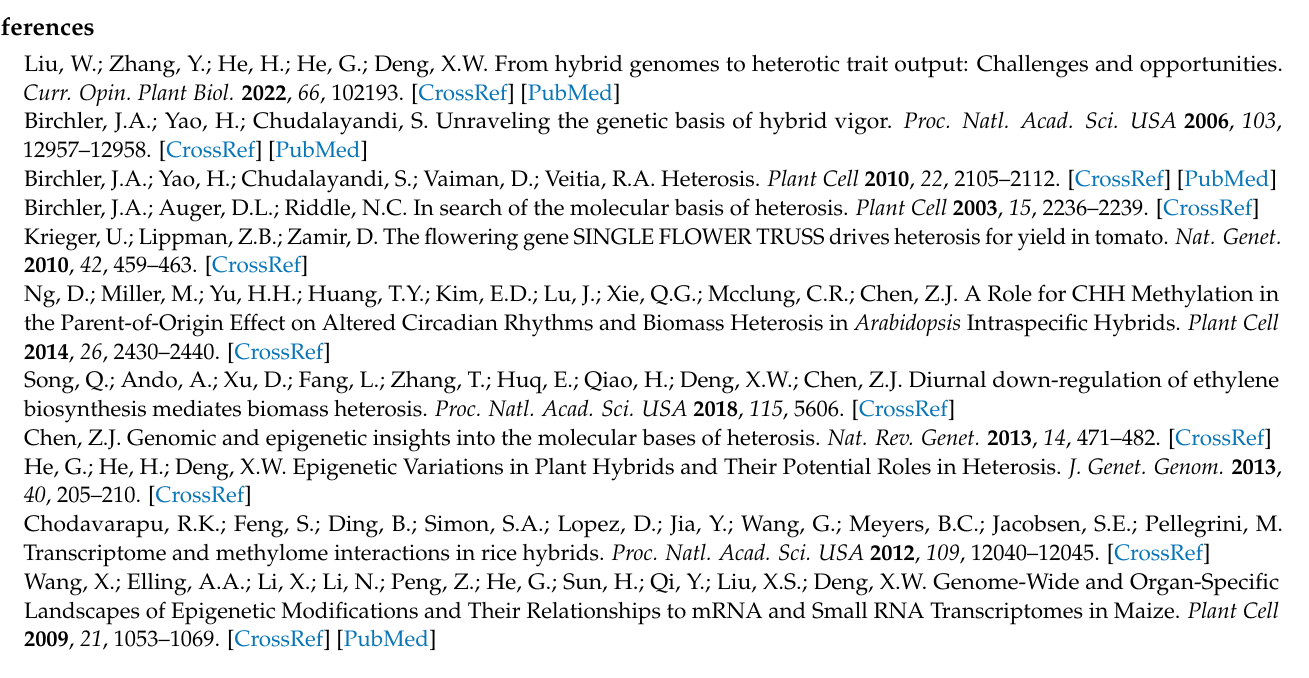
Figure S4: The methylation levels in parental selective difference sites for all combinations; Table S1: MethylRAD-seq data of all samples; Table S2: The super-methylated sites of all samples; Table S3: The reciprocal non-additive DMSs and DMGs of all cross combinations; Table S4: The reciprocal non-additive DMGs annotation for CCGG and CCWGG in all combinations; Table S5: GO enrichment analysis of reciprocal non-additive DMGs for CCGG and CCWGG sites in all combinations; Table S6: Non-additive methylation of transcription factors in the reciprocal hybrids; Table S7: Non-additive methylation of phytohormone-related genes in the reciprocal